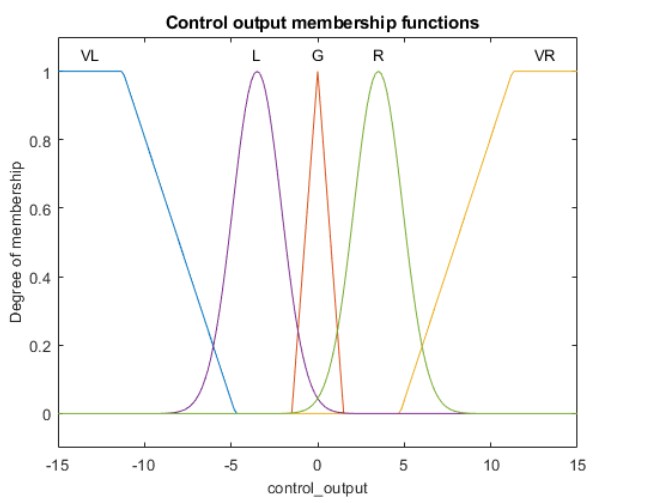
Figure 6. The membership functions of the control output set—the expert